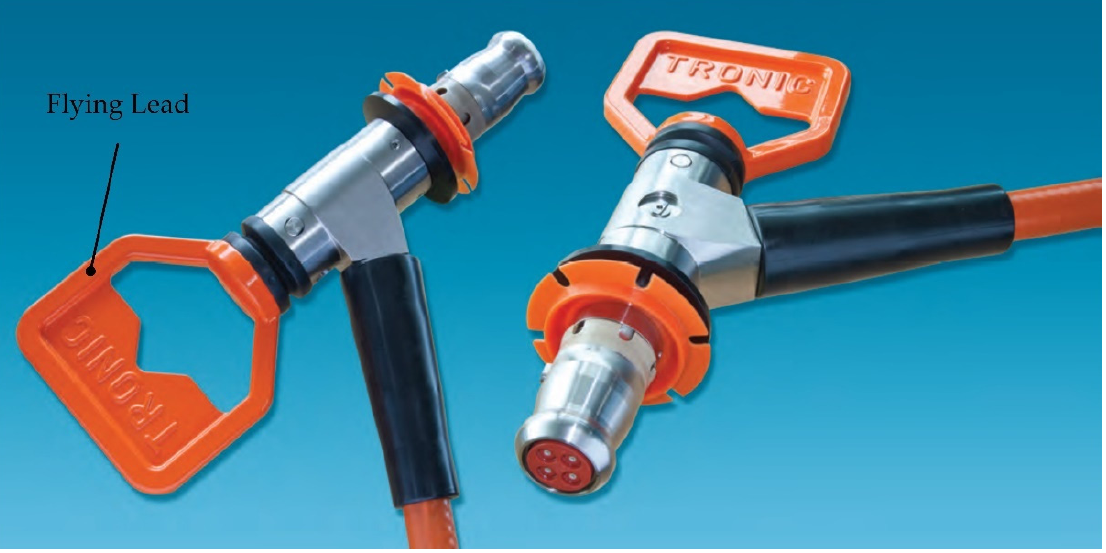
Figure 17. Siemens DigiTRON WMC with flying leads [89].